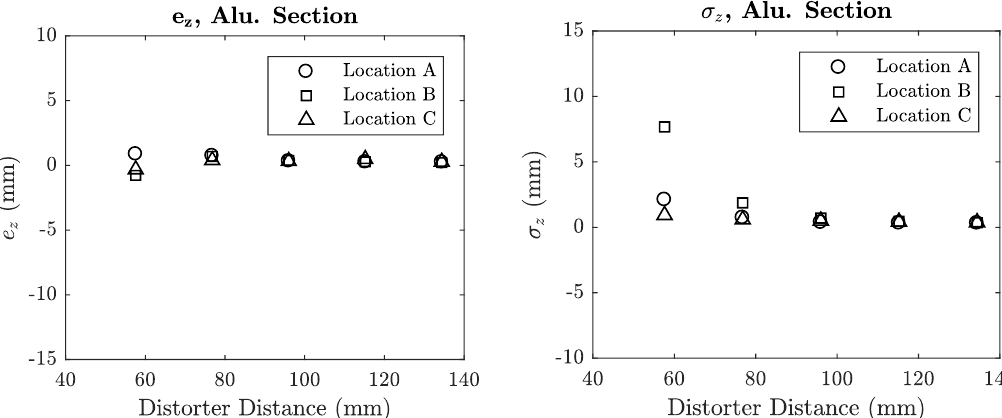
Figure A12. Position error plots for steel block, locations B and D.